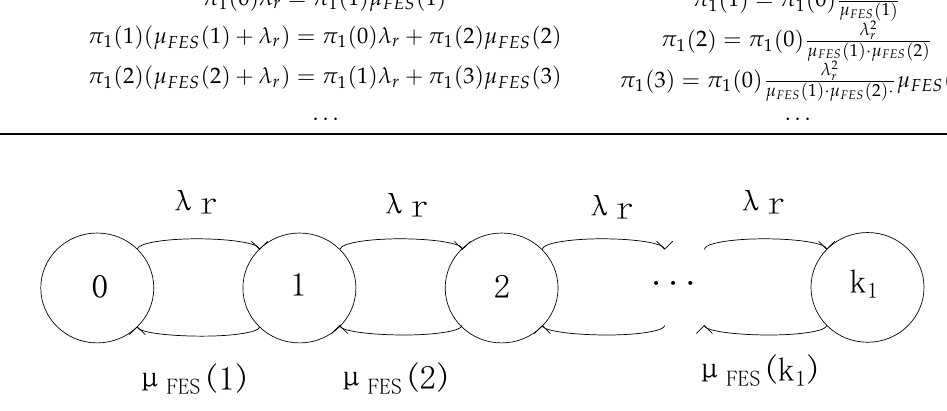
Figure 9. Extinction process.